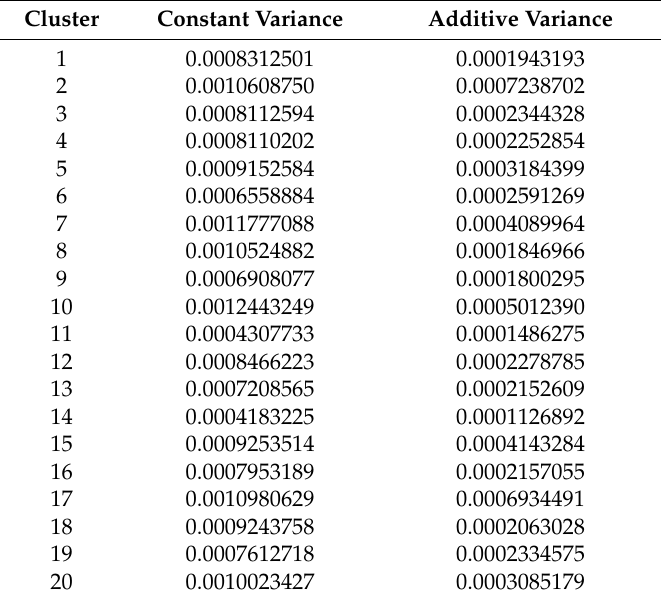
Table 3. Constant and additive